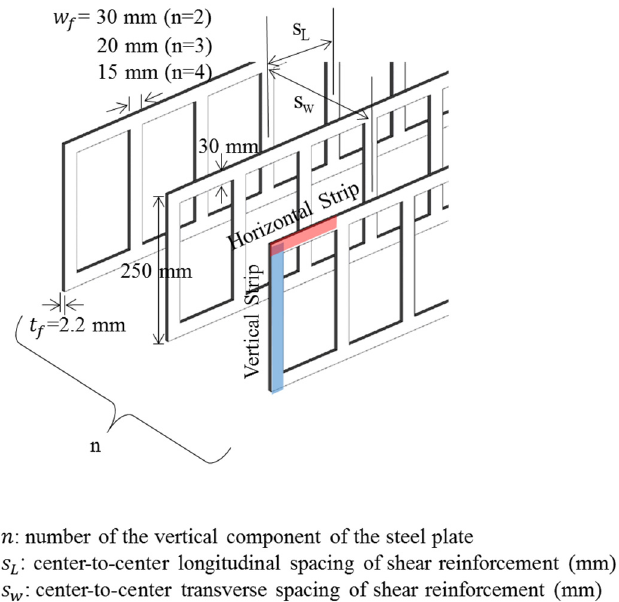
Figure 1. Shape of plate type of shear reinforcement.